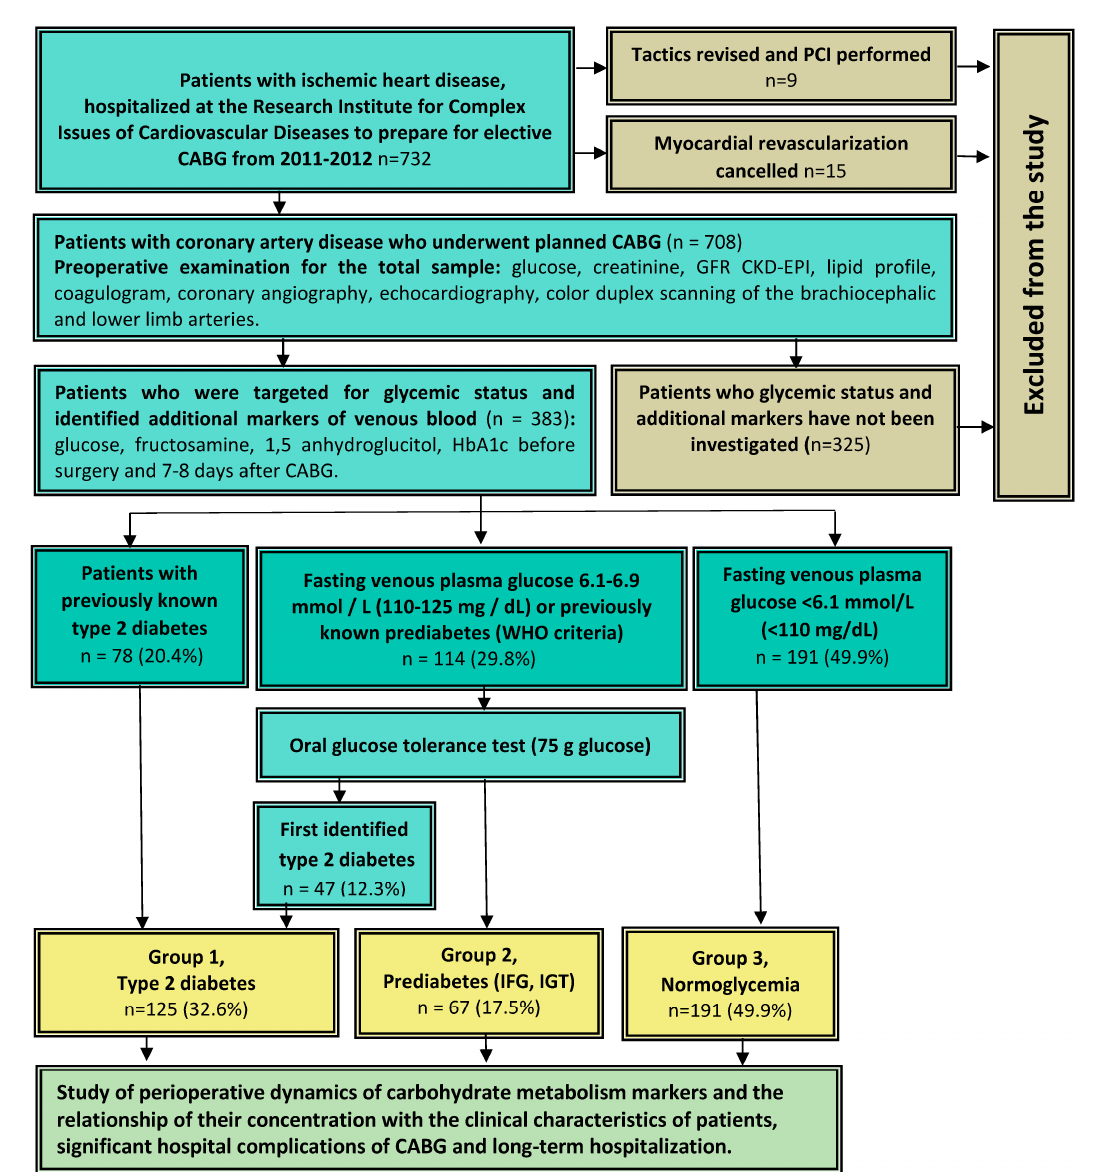
Figure 1. Study design. Notes: CABG—coronary artery bypass grafting, IVR—disorders of carbohydrate metabolism, IFG—impaired fasting glycemia, IGT—impaired glucose tolerance, GFR—glomerular filtration rate, CKD-EPI—Chronic Kidney Disease Epidemiology Collaboration. For patients with borderline fasting hyperglycemia according to the criteria of the World Health Organization/International Diabetes Federation (6.1–6.9 mmol/L (110–125